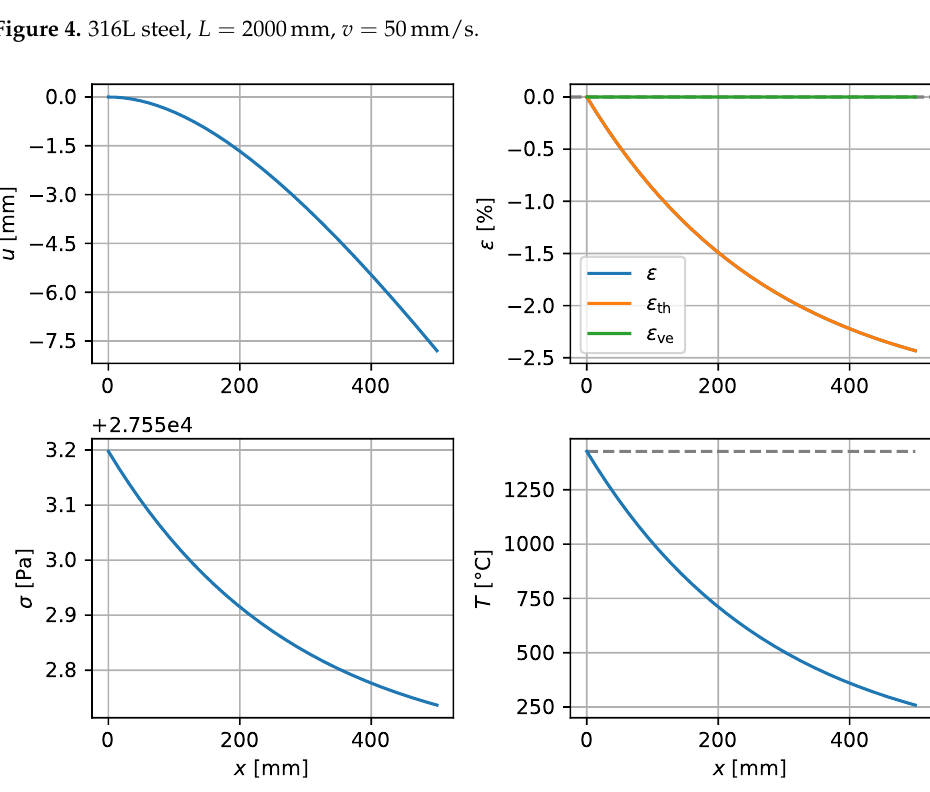
Figure 5. 316L steel, up to x = 500mm. v =